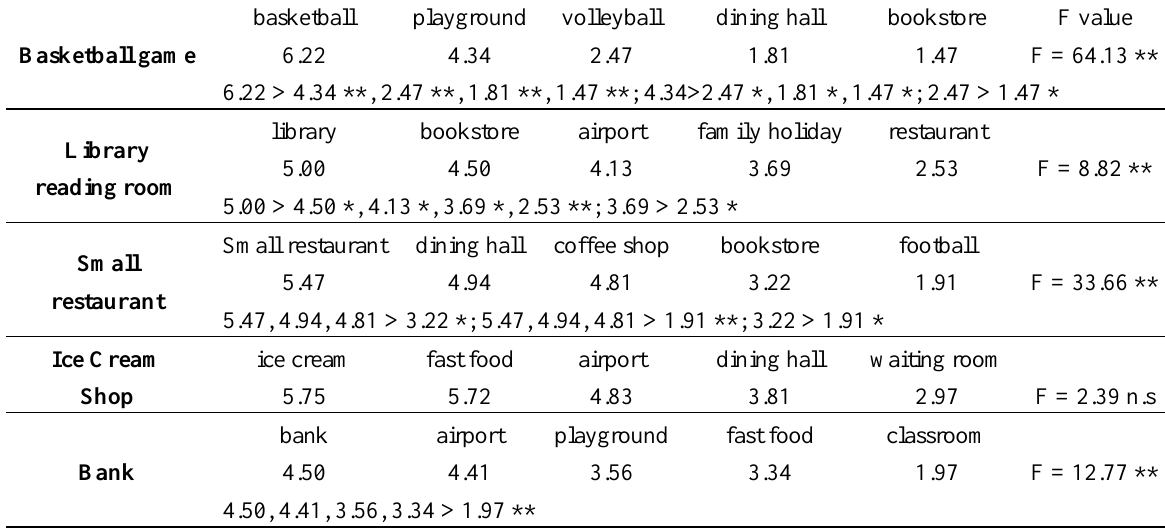
Table 4. Similarity ratings (1–7) for comparison settings relative to target settings